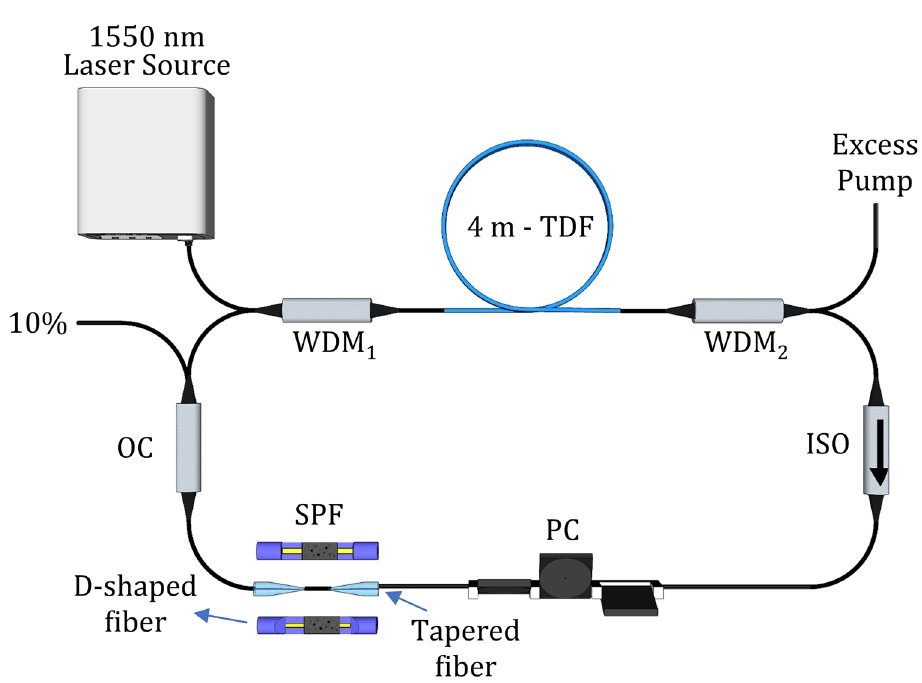
Figure 10. Illustration of the experimental setup for the 2 µm mode-locked Thulium-doped fiber laser (TDFL). This figure was drawn using SketchUp Make 2017 (Basic), Software Version: Windows 64-bit 17.2.2555. Available at https:// www. sketc hup. com/ downl oad/